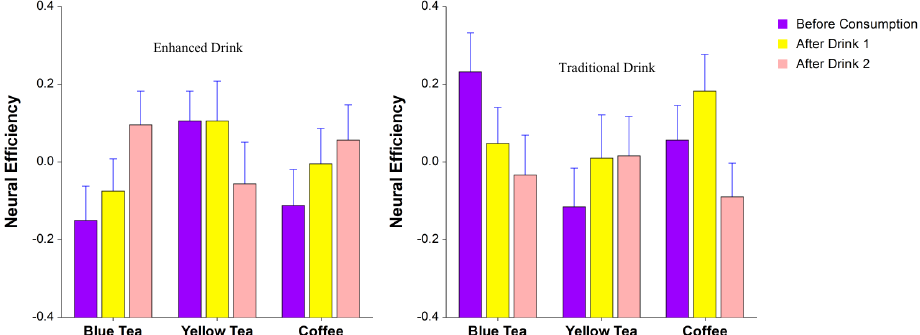
Figure 10. Comparison of neural efficiency in the RVP task. The left graph indicates neural efficiency while participants consumed the enhanced drink. The right graph indicates neural efficiency while participants consumed the traditional drink. Whiskers represent the SEM.